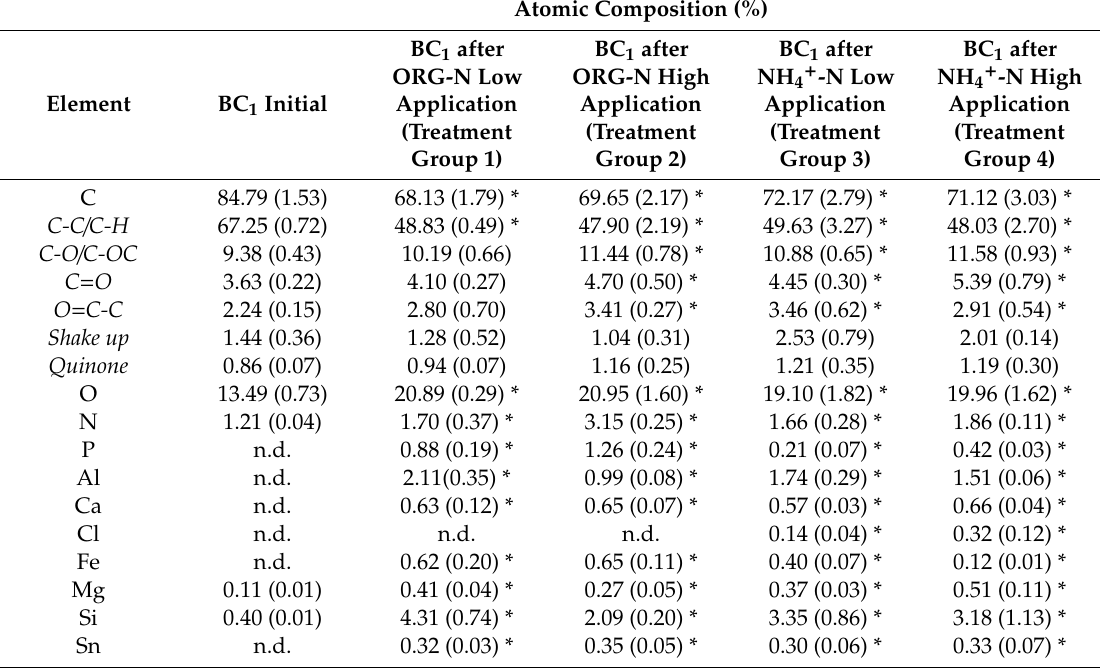
Table 3. X-ray photo-electron spectroscopy (XPS) scan of major elements and functional groups on the surface of BC 1 before and after soil amendment for columns receiving ORG-N and NH 4 + -N low and high application rates. Value is mean (standard deviation) from triplicate columns. Significant di ff erence ( p = 0.05) between BC 1 initial and BC 1 final for treatments one through four are denoted with an asterisk (*). Elemental peaks that were not detected are signified by